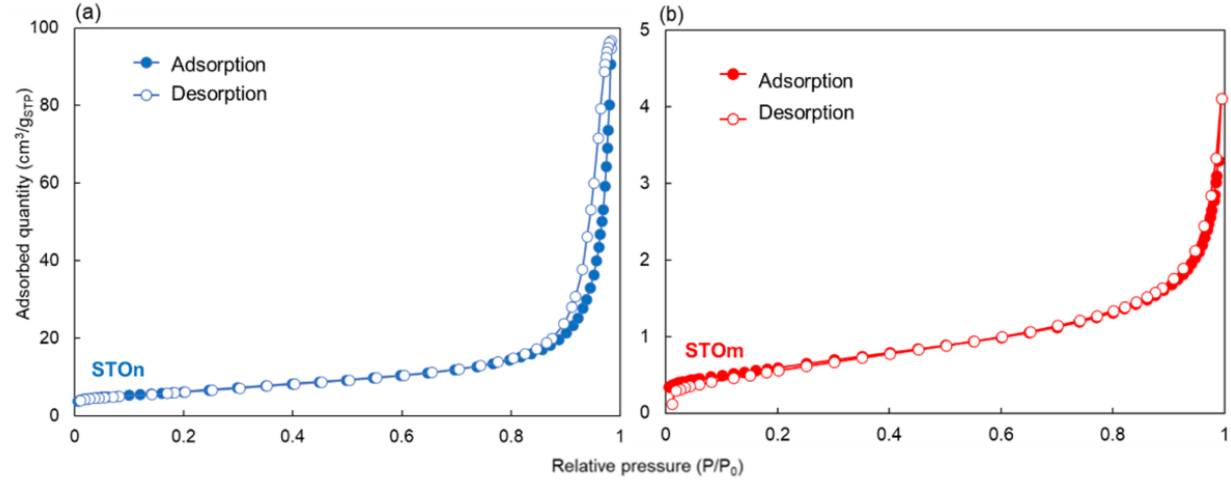
Figure 2. N 2 adsorption/desorption isotherms at −196 °C for STOn ( a ) and STOm ( b ). They possess a hysteresis zone (H3 type, de Boer’s classification), typical of mesoporous materials, and only minor microporosity [62,63]. In particular, STOm is characterized by a lower value of specific surface area than STOn (respectively, 2 vs. 21 m 2 ·g −1 ), in accordance with XRPD results.